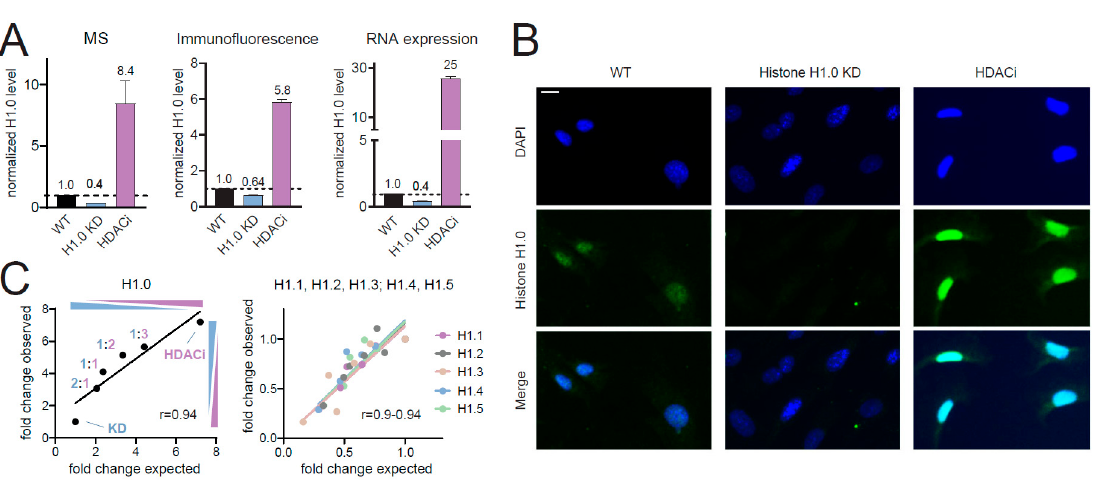
Figure 2. Comparison with other approaches. ( A ) Histone H1.0 protein levels in MEF cells WT, H1.0 KD and treated with the histone deacetylates inhibitor (HDACi) quisinostat, as measured by MS or immunofluorescence (left and central panels), and mRNA levels (right panel) in the same samples. Error bars represent the SEM from biological triplicates. ( B ) Immunofluorescence staining of histone H1.0 in the samples described in ( A ). Scale bar: 10 µm. ( C ) H1.0 KD cells and cells treated with HDACi were mixed in different proportions, and the different histone H1 isoforms were quantified by MS. The plots show the expected and observed fold changes between each sample and the H1.0 KD sample (refer to Figure S1 for more details).